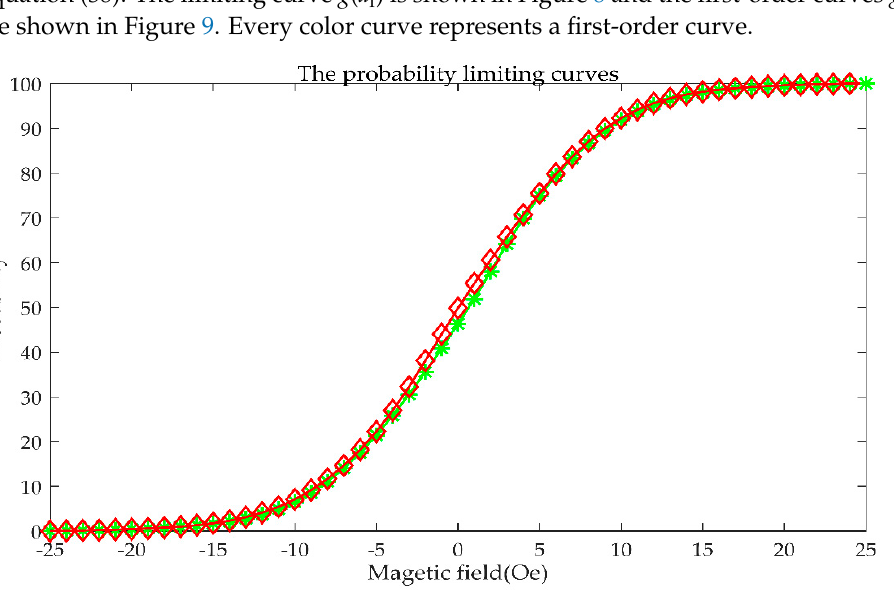
Figure 8. The limiting curve of the probability model.